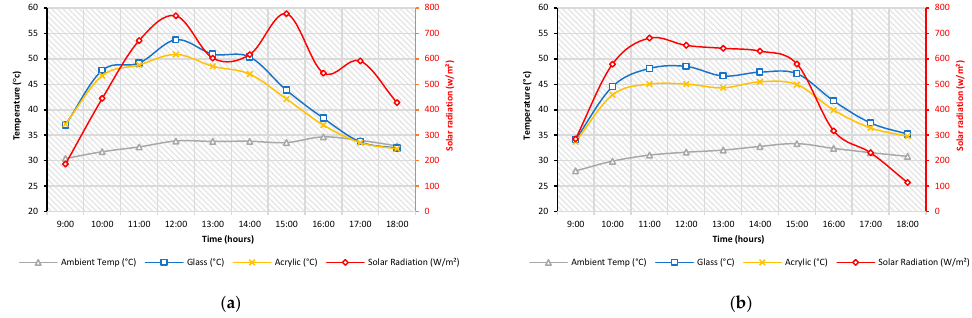
Figure 14. Variation in solar intensity and outer cover temperature: ( a ) 21 February 2020 and ( b ) 1 August 2020.